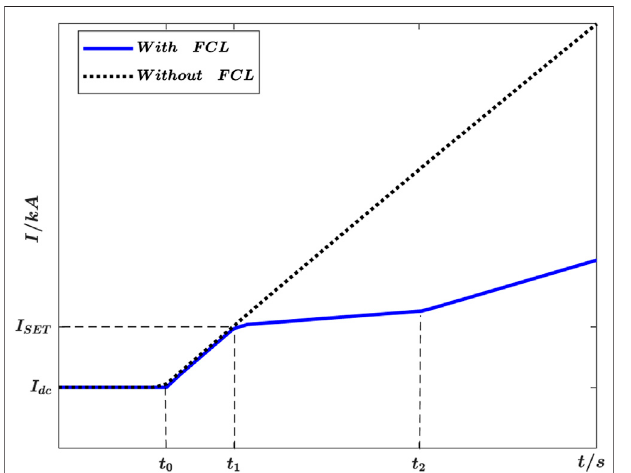
FIGURE 1 | Fault current with FCLs and without FCLs.